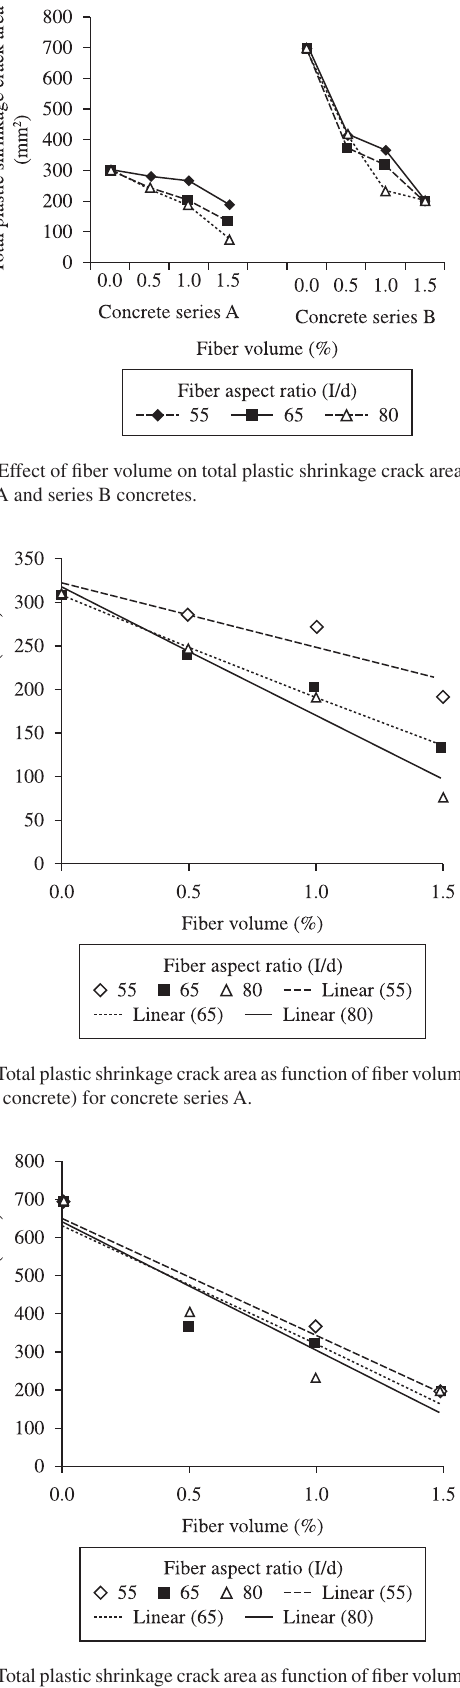
Figure 8. Total plastic shrinkage crack area as function of fiber volume (% by volume of concrete) for concrete series